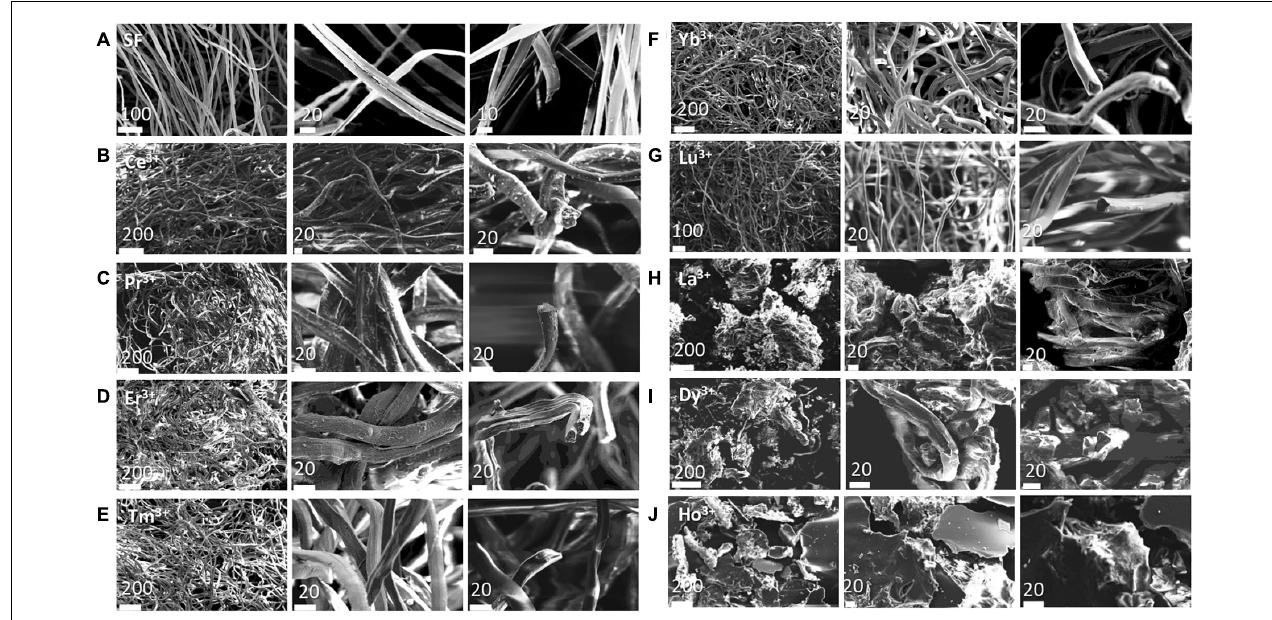
FIGURE 2 | SEM images of the Analyzed samples at two scale bars in µ m (indicated on each figure) with the cross-sectional views. (A) degummed SF; (B) Ce + 3 /SF; (C) Pr + 3 /SF; (D) Er + 3 /SF; (E) Tm + 3 /SF; (F) Yb + 3 /SF; (G) Lu + 3 /SF; (H) La + 3 /SF; (I) Dy + 3 /SF; (J) Ho + 3 /SF.